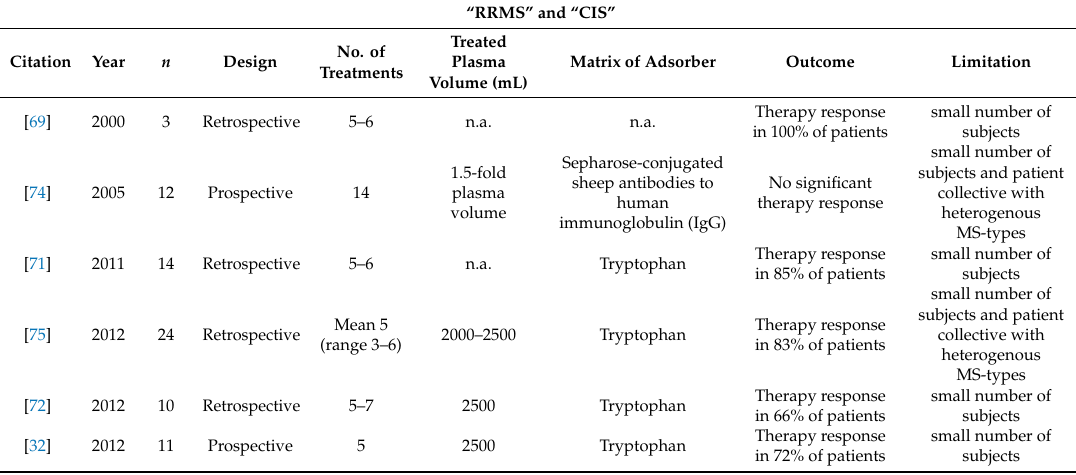
Table 2. Studies on immunoadsorption in treatment of relapsing-remitting multiple sclerosis (RRMS), clinically isolated syndrome (CIS) and neuromyelitis optica (NMO). “RRMS” and